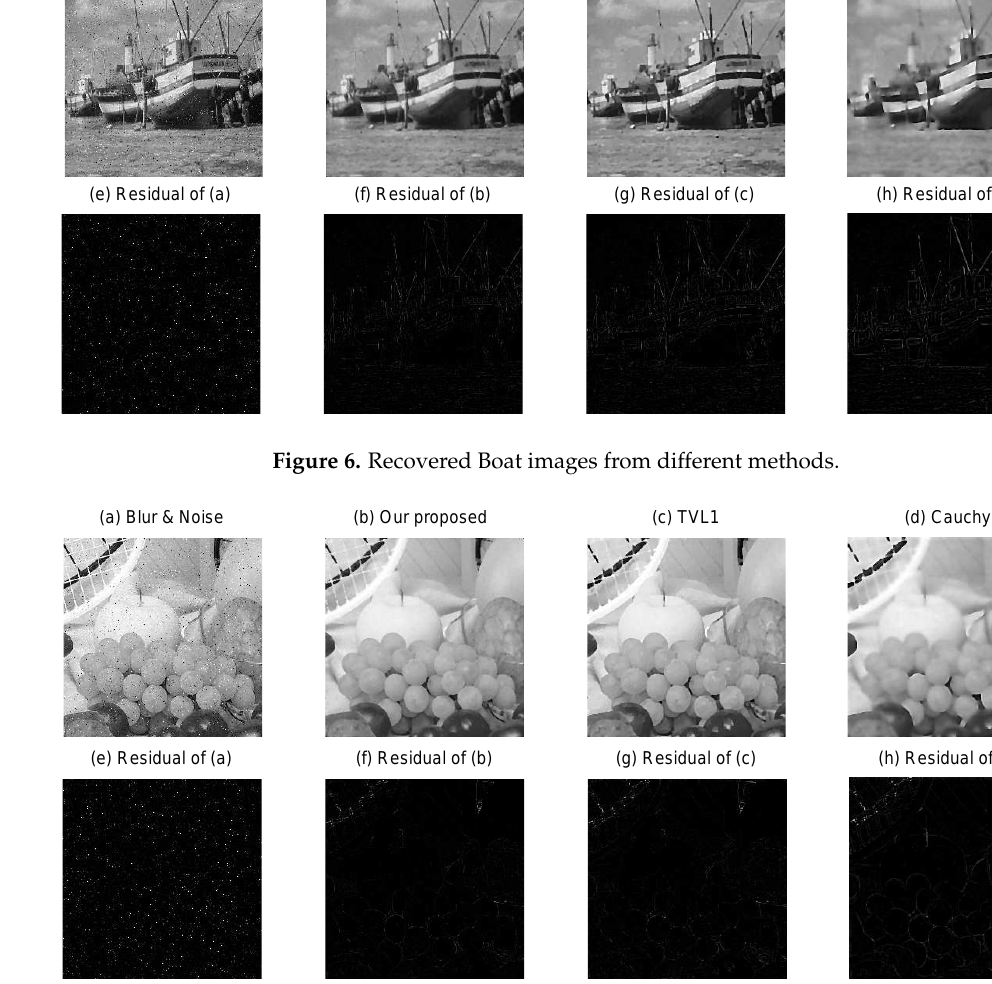
Figure 7. Recovered Fruits images from different